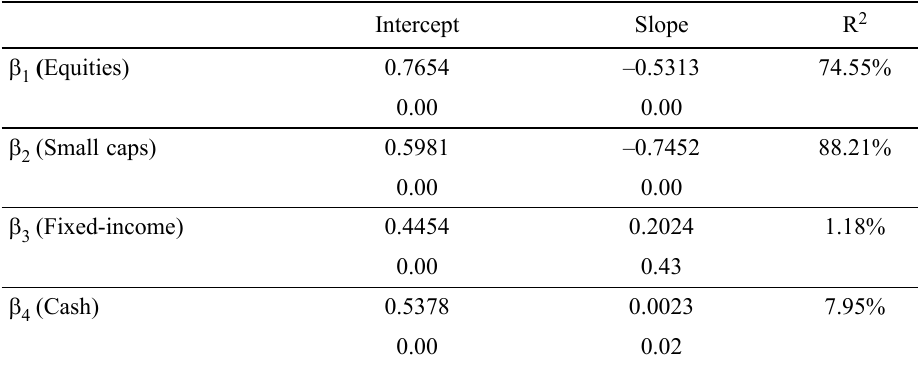
Table A.1. Relationship between the probability of increasing an